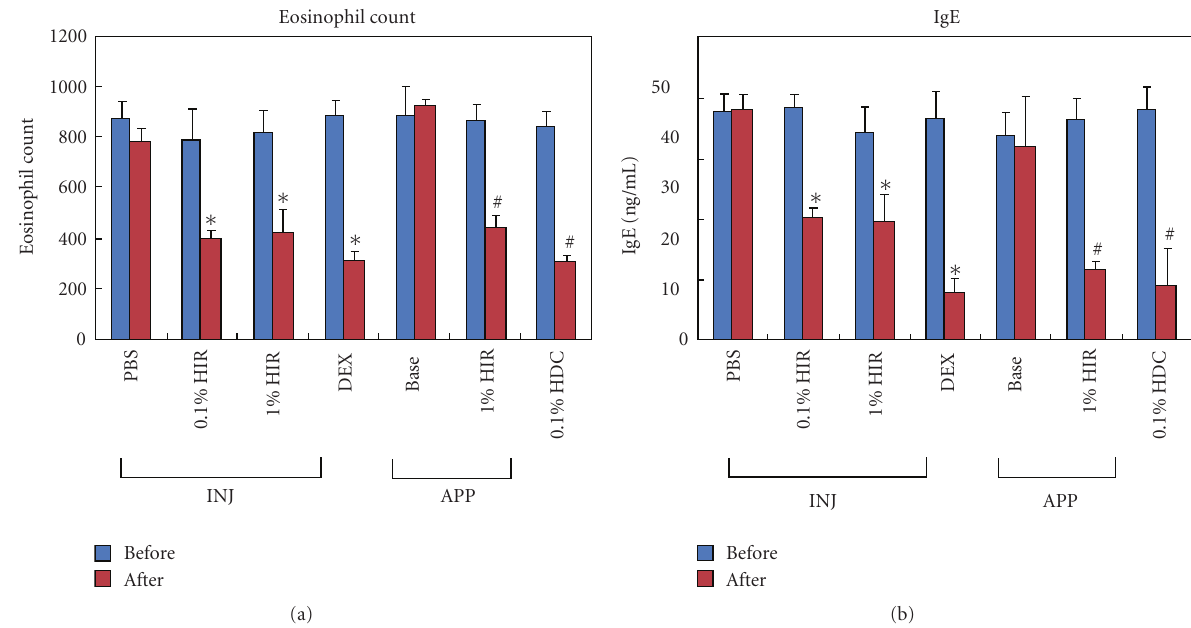
Figure 3: Changes in eosinophil counts and IgE levels before-to-after HIR treatment. Numbers of eosinophils reduced after HIR treatment. HIR significantly reduced plasma IgE levels. Data are shown as mean ± S.D. HIR = Hirsutenone, DEX = dexamethasone, Base = Baseline, HDC = hydrocortisone cream, INJ = injection, APP = application. ∗ P < .05 compared with the PBS group. # P < .05 compared with the Base group. n = 5/group.